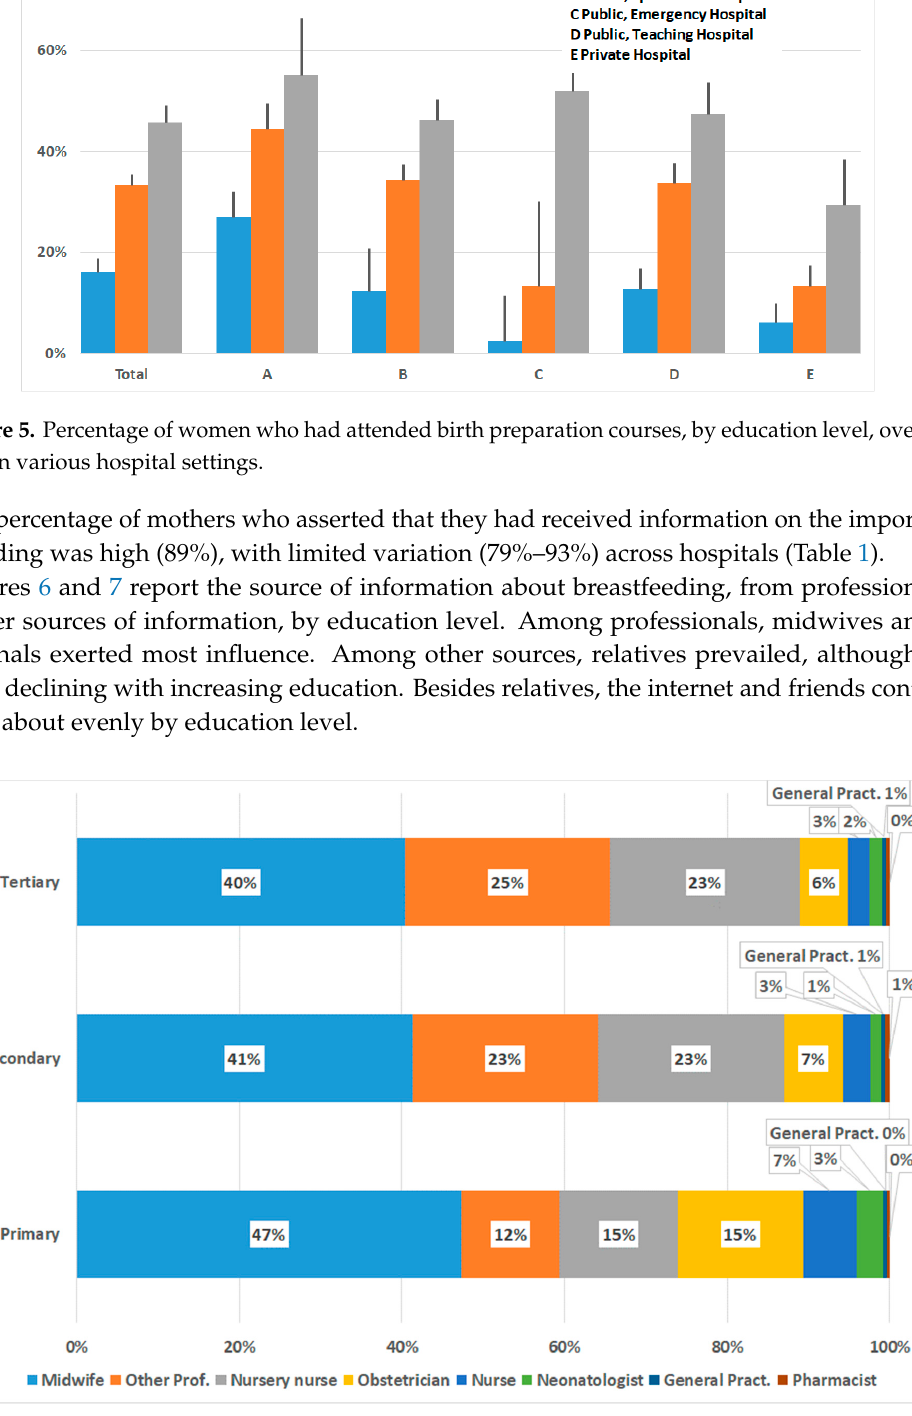
Figure 7. Other sources of information for mothers, according to women’s levels of education.